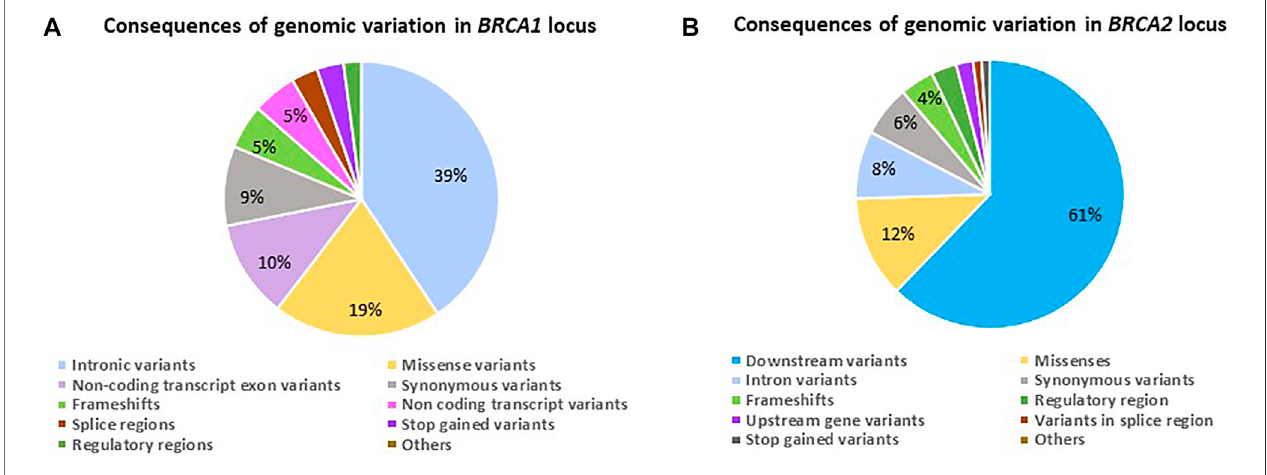
FIGURE2| Diagramsindicatingthegenomicvariantfrequenciesforthe BRCA1 and BRCA2 lociamongst1,089patientsscreenedusingNGS. (A) Theconsequence ratios relative to variant frequencies observed for the BRCA1 locus. (B) The consequence ratios relative to variant frequencies observed for the BRCA2 locus.